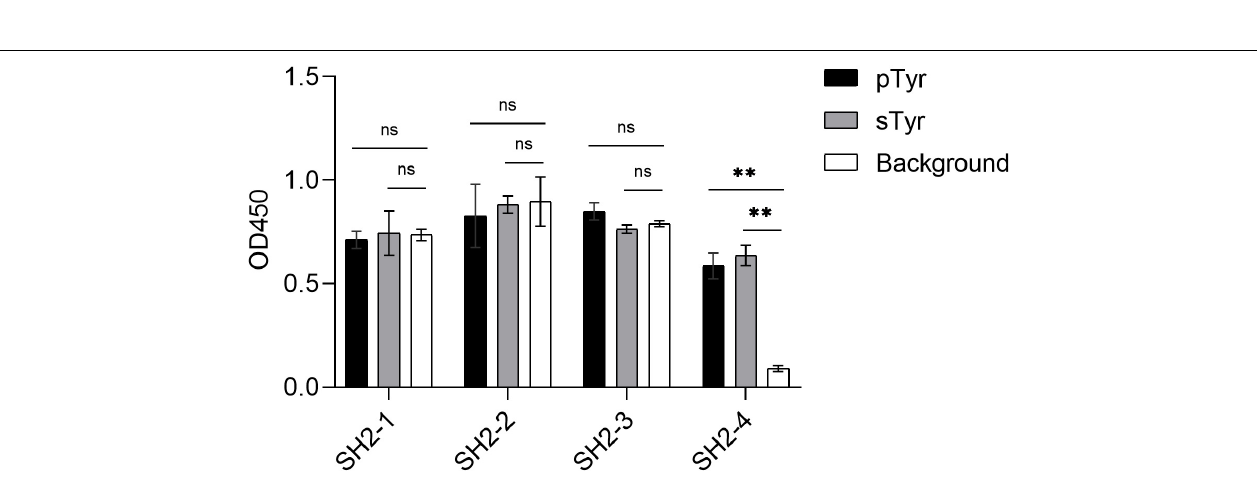
Frontiers in Microbiology |